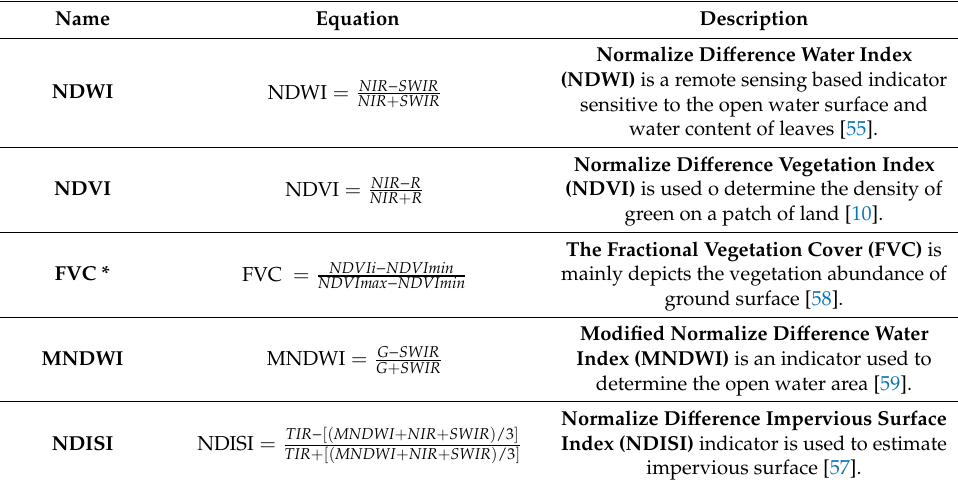
Table 4. Spectral indexes of Landsat image used in this